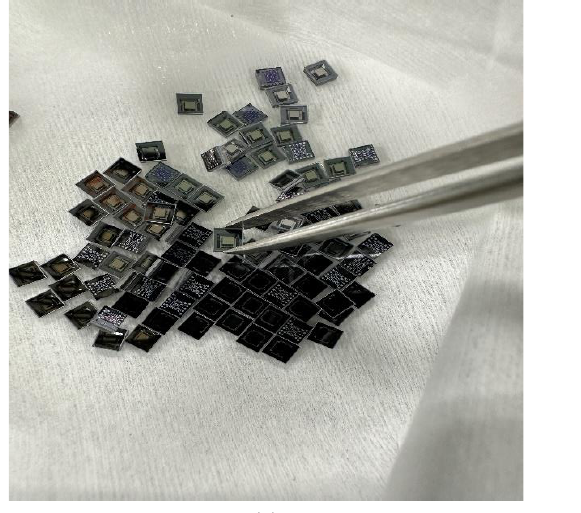
Figure 6. ( a ) Picture of composite wafer. ( b ) SEM image of the MEMS structure. ( c ) Photograph of wafer-level package MEMS butterfly vibratory gyroscope. ( d ) Microscopic image of a single packaged gyroscope.